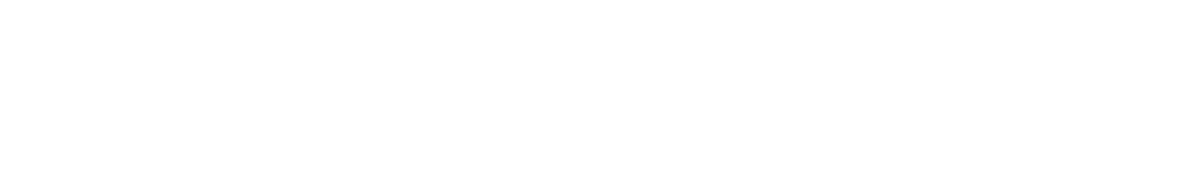
Frontiers in Nutrition |